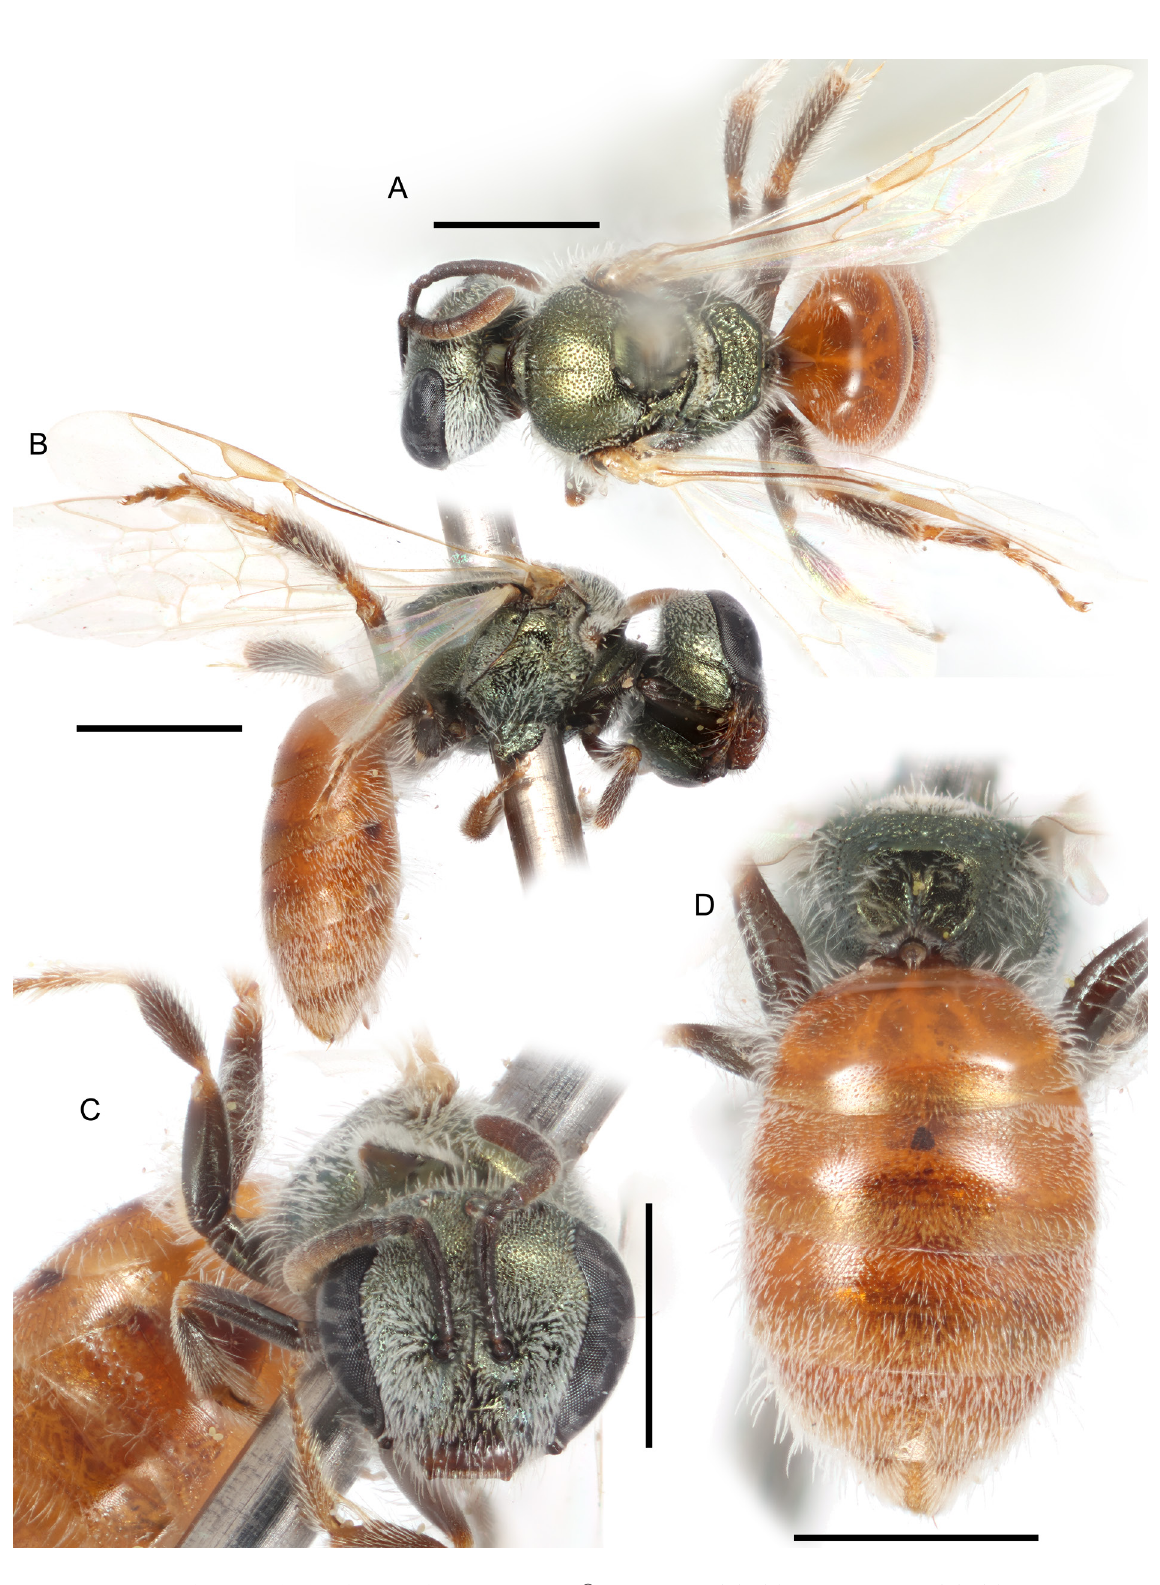
Fig. 22. Lasioglossum ( D. ) clastipedion sp. nov., ♀. A . Dorsal habitus. B . Lateral habitus. C . Face. D . Propodeum and metasoma. Scale bars: 1